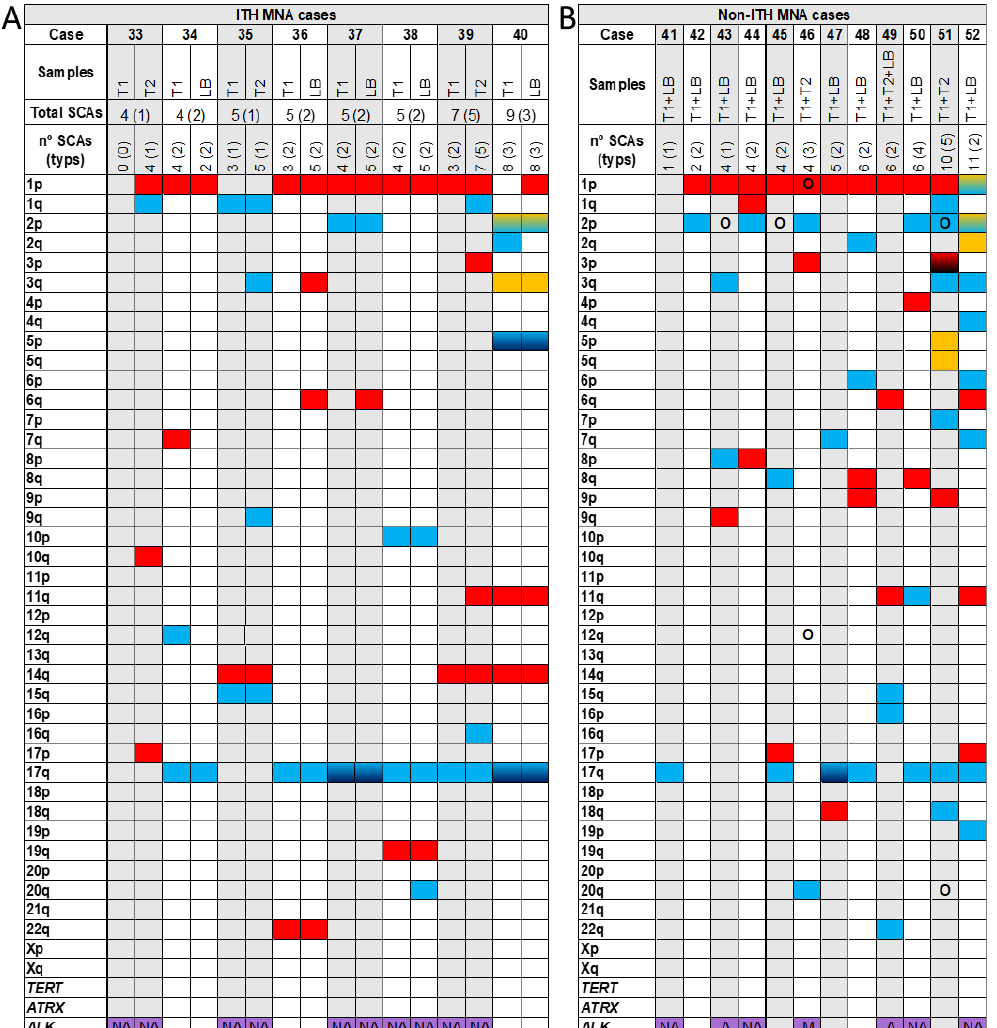
the sample; +: refers to the presence of ALT; A: refers to presence of ALK amplification; M: indicates ALK mutation. O: indicates amplification of any gene or region in the chromosome arm, excluding MYCN or ALK amplification.